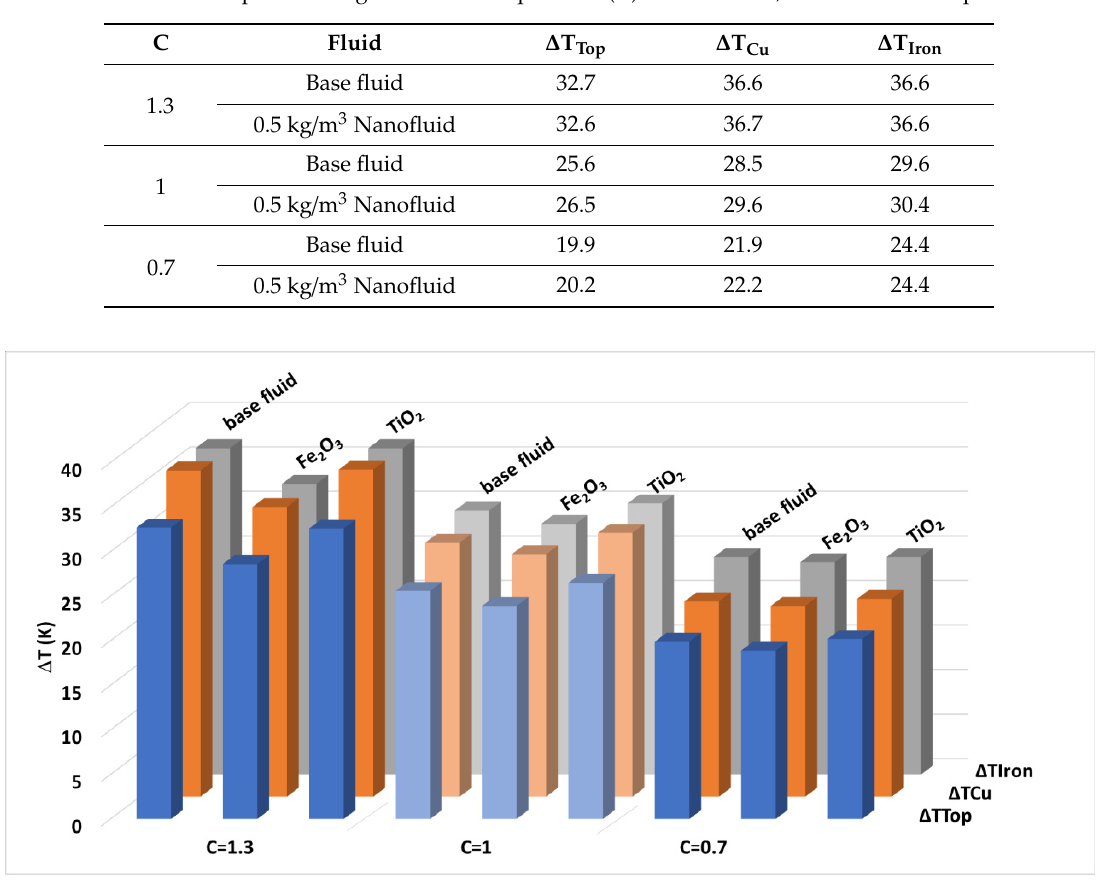
Figure 10. Temperature gradients found in each probe with di ff erent load conditions and cooling fluids.